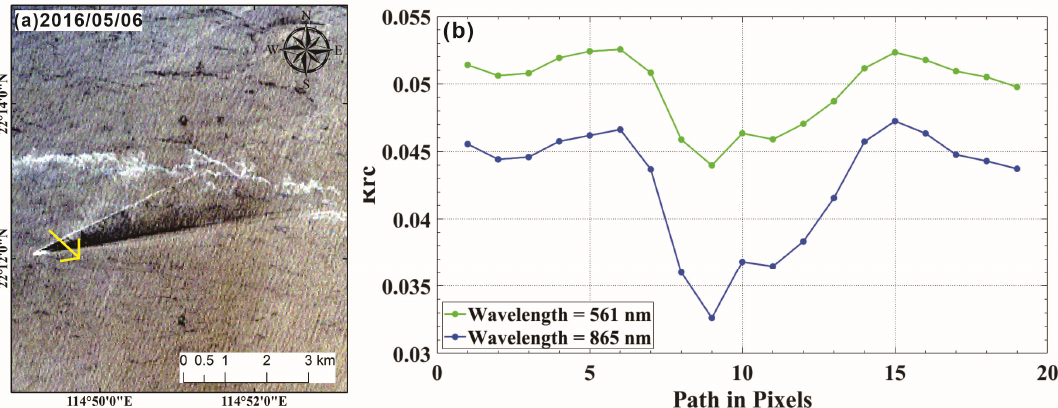
Figure 4. ( a ) Ship wakes on the ocean surface; ( b ) Rrc spectra at 561-nm and 865-nm bands along the transect marked in panel a (yellow arrow).